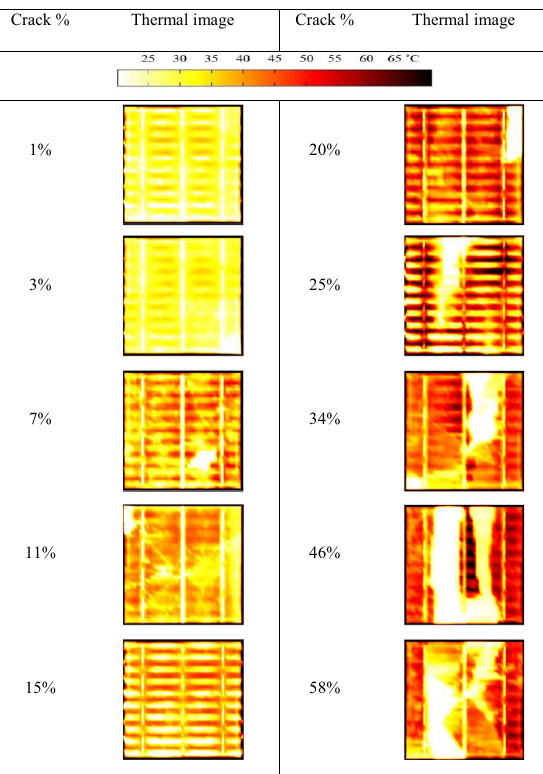
Table 2. Thermal images of the examined solar cell samples under STC conditions.